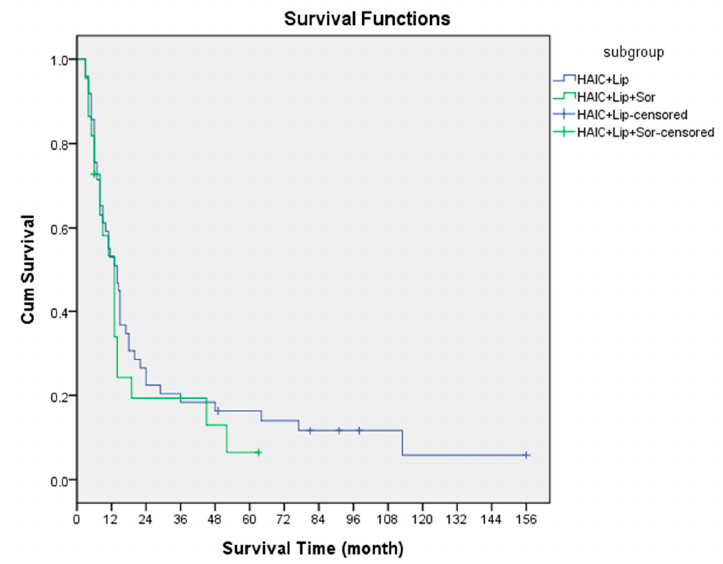
Figure 4. OS of the with and without sorafenib therapy patient subgroups.